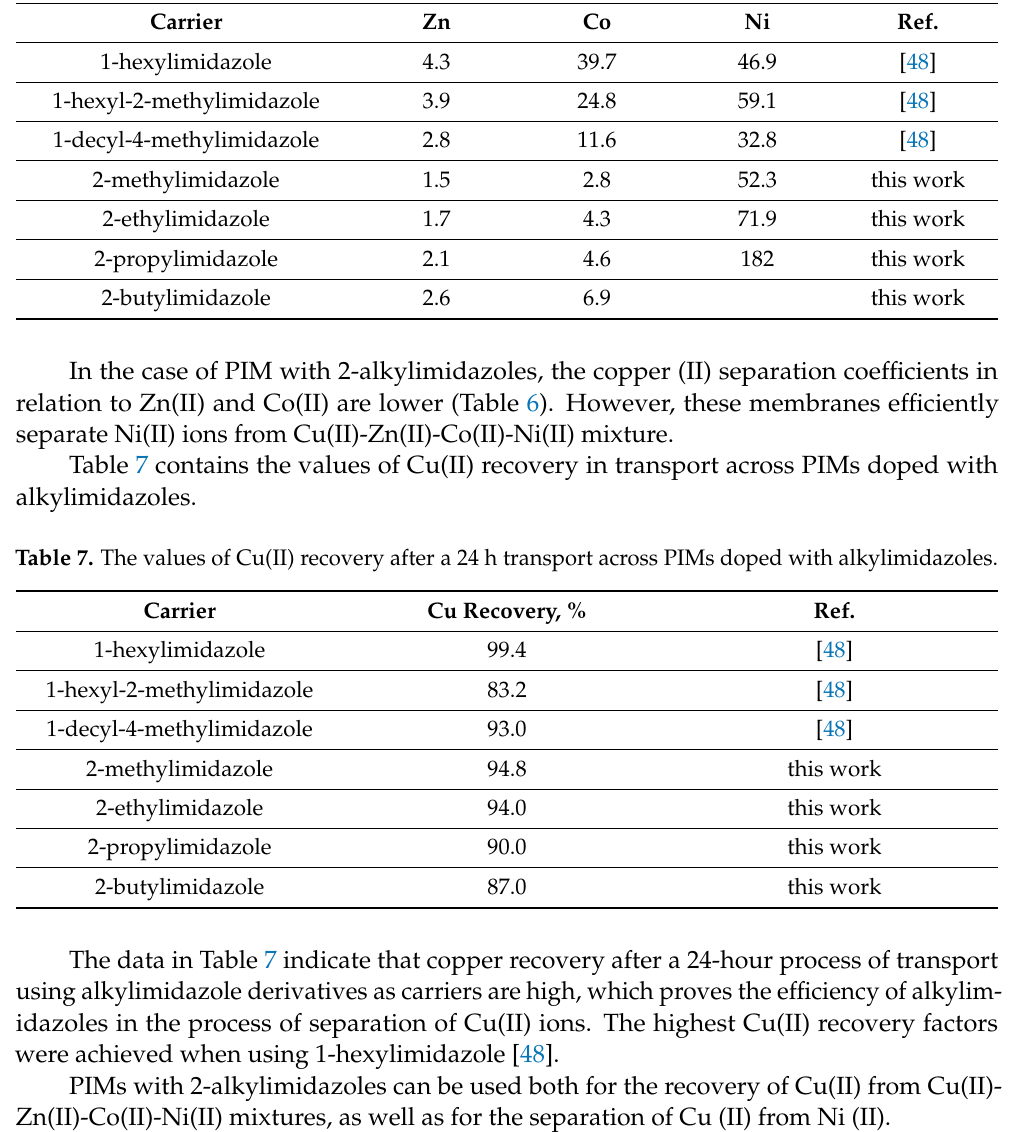
Table 6. The copper (II) separation coefficients in relation to Zn(II), Co(II), and Ni(II) from their equimolar solutions after a 24 h transport across PIMs with alkylimidazoles. Separation Coefficients Cu(II)/M(II) Carrier Zn Ref.